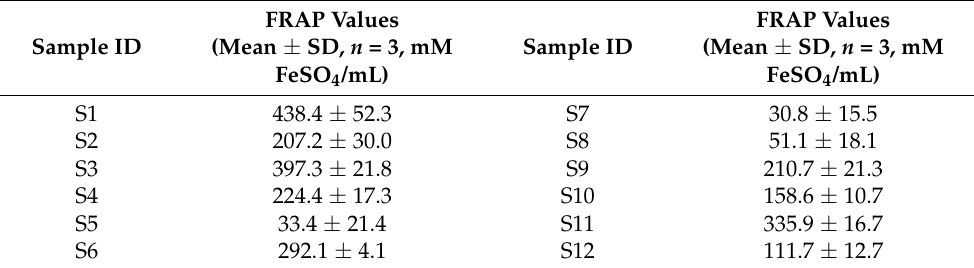
Table 4. The results of FRAP assay.